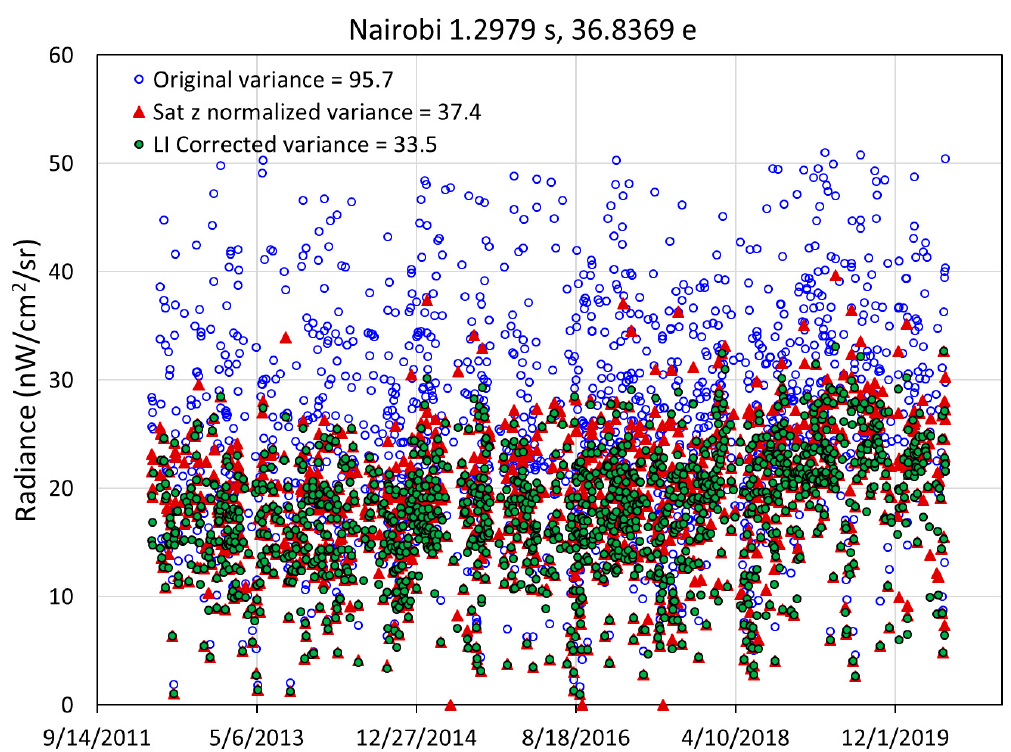
Figure 44. Temporal profiles from a grid cell in Nairobi showing the variance reducing in a stepwise fashion following the satellite zenith, normalization, and lunar illuminance correction. In total, the variance drops 65%.